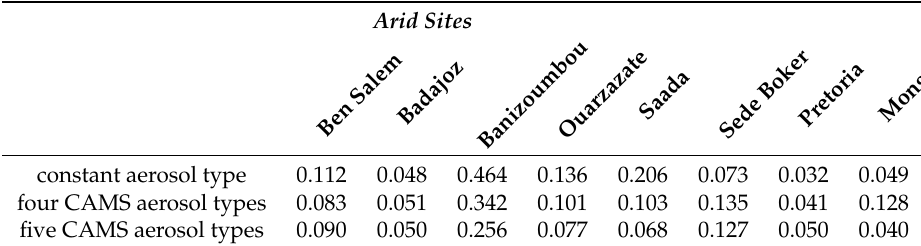
Table 4. Root-mean-square error (RMSE) of aerosol optical thickness (AOT) at 550 nm estimated by the MACCS-ATCOR Joint Algorithm (MAJA), over each arid site. CAMS: Copernicus Atmosphere Monitoring Service.